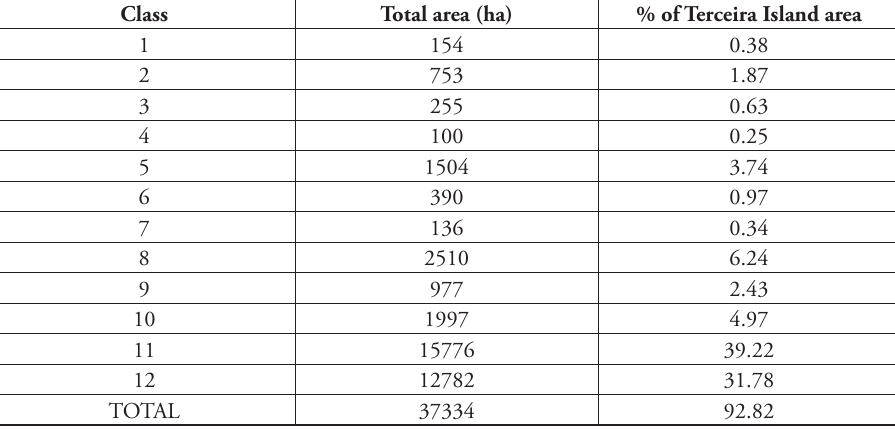
Table 4. Spatial assessment of insect pollinators’ abundance classes in Terceira Island